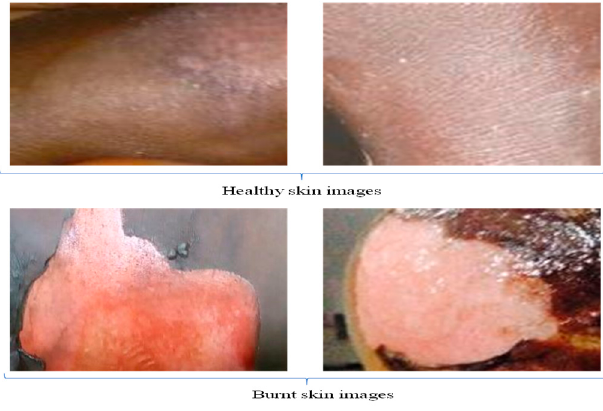
Figure 1. Sample of the dataset.